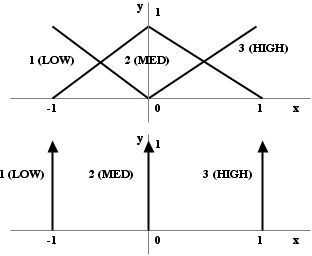
Numerical-Fuzzy Data Conversion. Fuzzification (top) and defuzzification (bottom) schemes used in this analysis, showing conversion to and from values in the interval [-1,1] on the x-axis and fuzzy sets LOW (1), MED (2), and HIGH (3). See text for details.